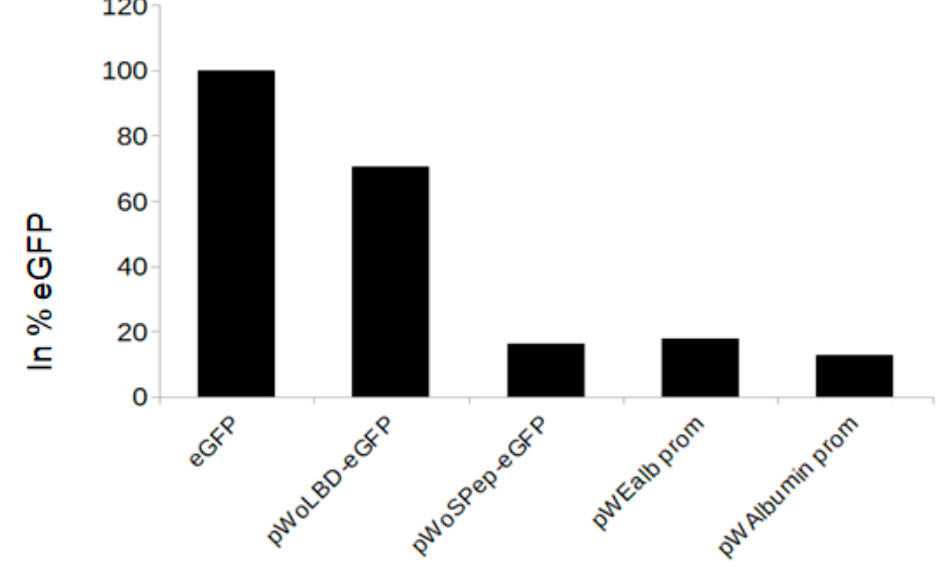
Figure 3. Transduction of HepG2 / 293T cells with supernatant from constructs under liver-specific promoter or presents deletions at 3’ of LDLReGFP. After transfection with constructs harboring eGFP gene only, constructs with LDLReGFP cassette under the liver-specific promoter or LDLReGFP constructs with deletions at 3’ of LDLReGFP, the same amount of the supernatants was used for the transduction of the HepG2 / 293T cells, as described in the materials and methods section, the transduction efficiency was presented in % of GFP.